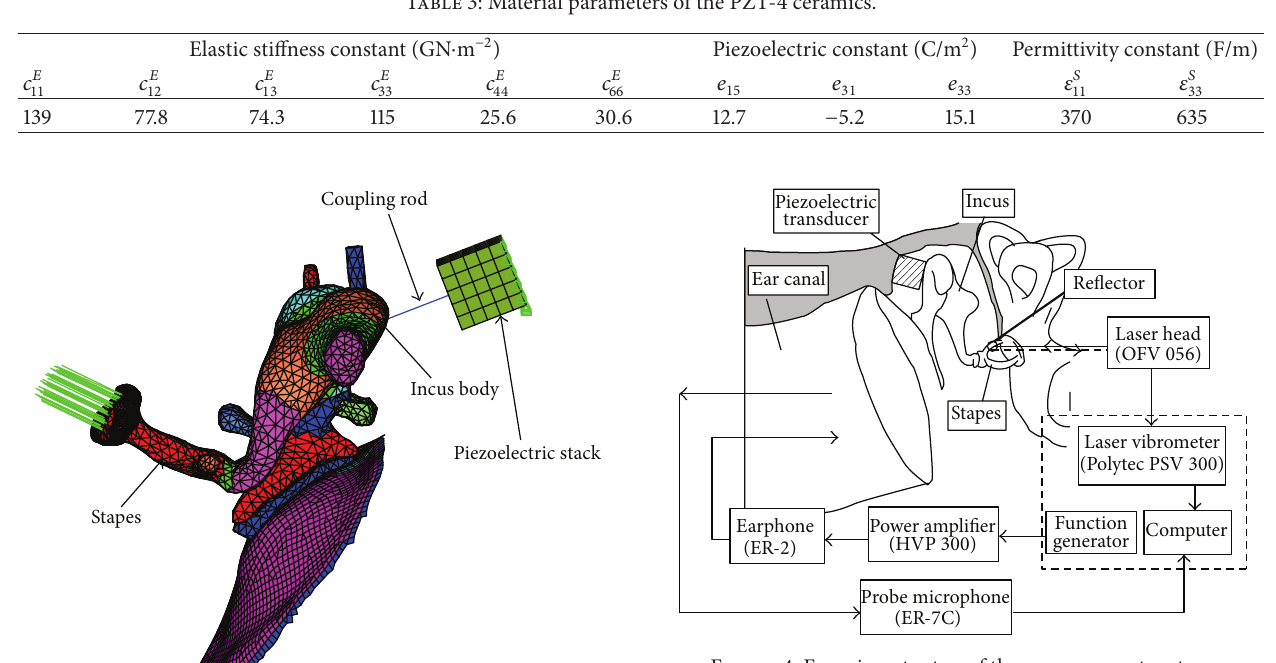
Figure 4: Experiment setup of the measurement system.